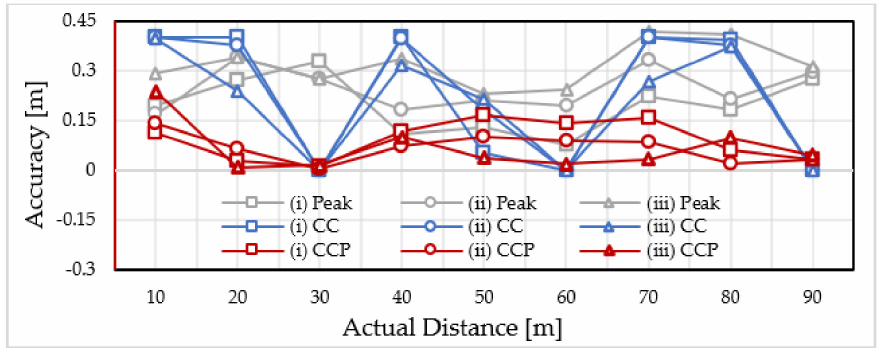
Figure 16. The accuracies of the peak, CC, and CCP methods are determined in different background light environments.